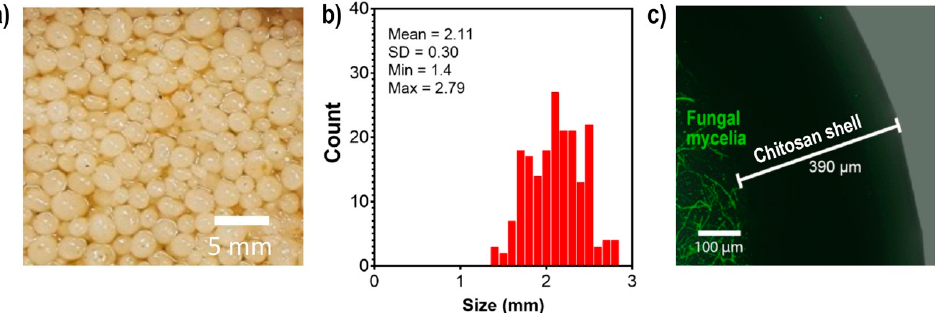
Figure 2. Image ( a ), size distribution ( b ), and CLSM image ( c ) of chitosan fungal beads of S. hirsutum for use in multiple extractions and nanoparticle synthesis .